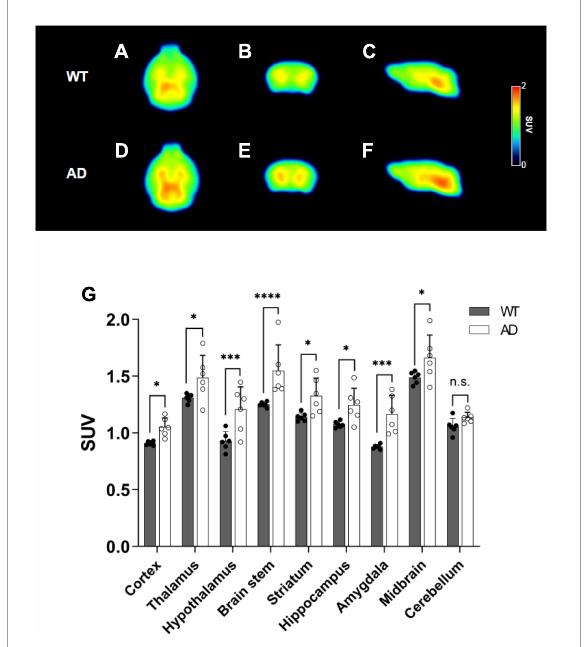
FIGURE3 Summed positron emission tomography (PET) images (10–30 min) of 18 F-florbetaben in the wild-type (WT) (A–C) and Alzheimer’s disease (AD) groups (D–F) . Comparison of the standardized uptake values (SUVs) for the brain regions (G) at 10–30 min. Values are presented as the mean ± SD ( n = 6). Statistical significance was defined as a p value less than 0.05 for comparisons between groups (* p < 0.05, *** p < 0.001 and **** p <